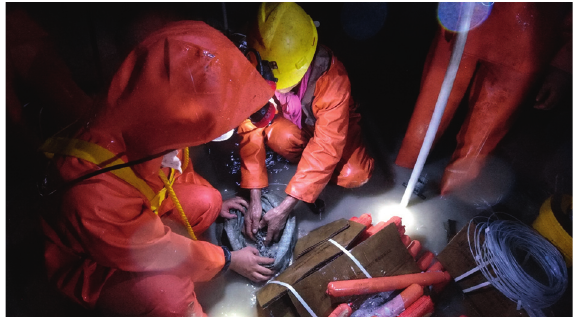
Figure 16: Cut blasting charging in field.